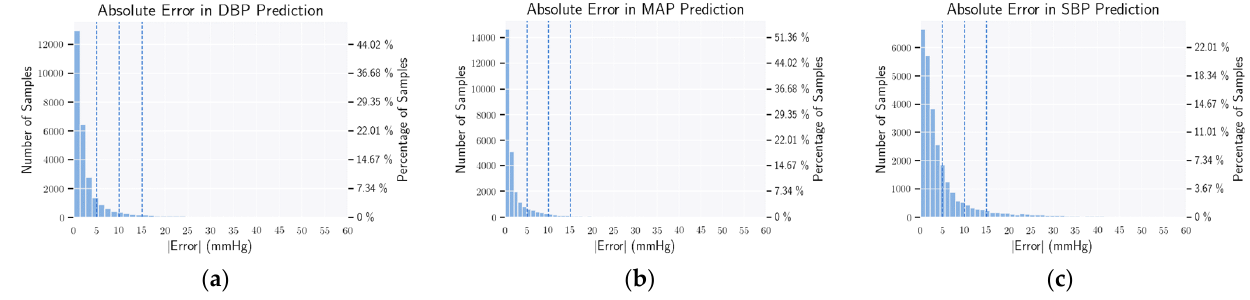
Figure 5. Mean absolute error histogram. Here, we present how the absolute errors of predicting DBP, SBP, and MAP of the samples are distributed. In addition, we also observe errors in how many samples lie below the 5 mmHg ( a ), 10 mmHg ( b ), and 15 mmHg ( c ) thresholds, used in the evaluation of the BHS Standard.